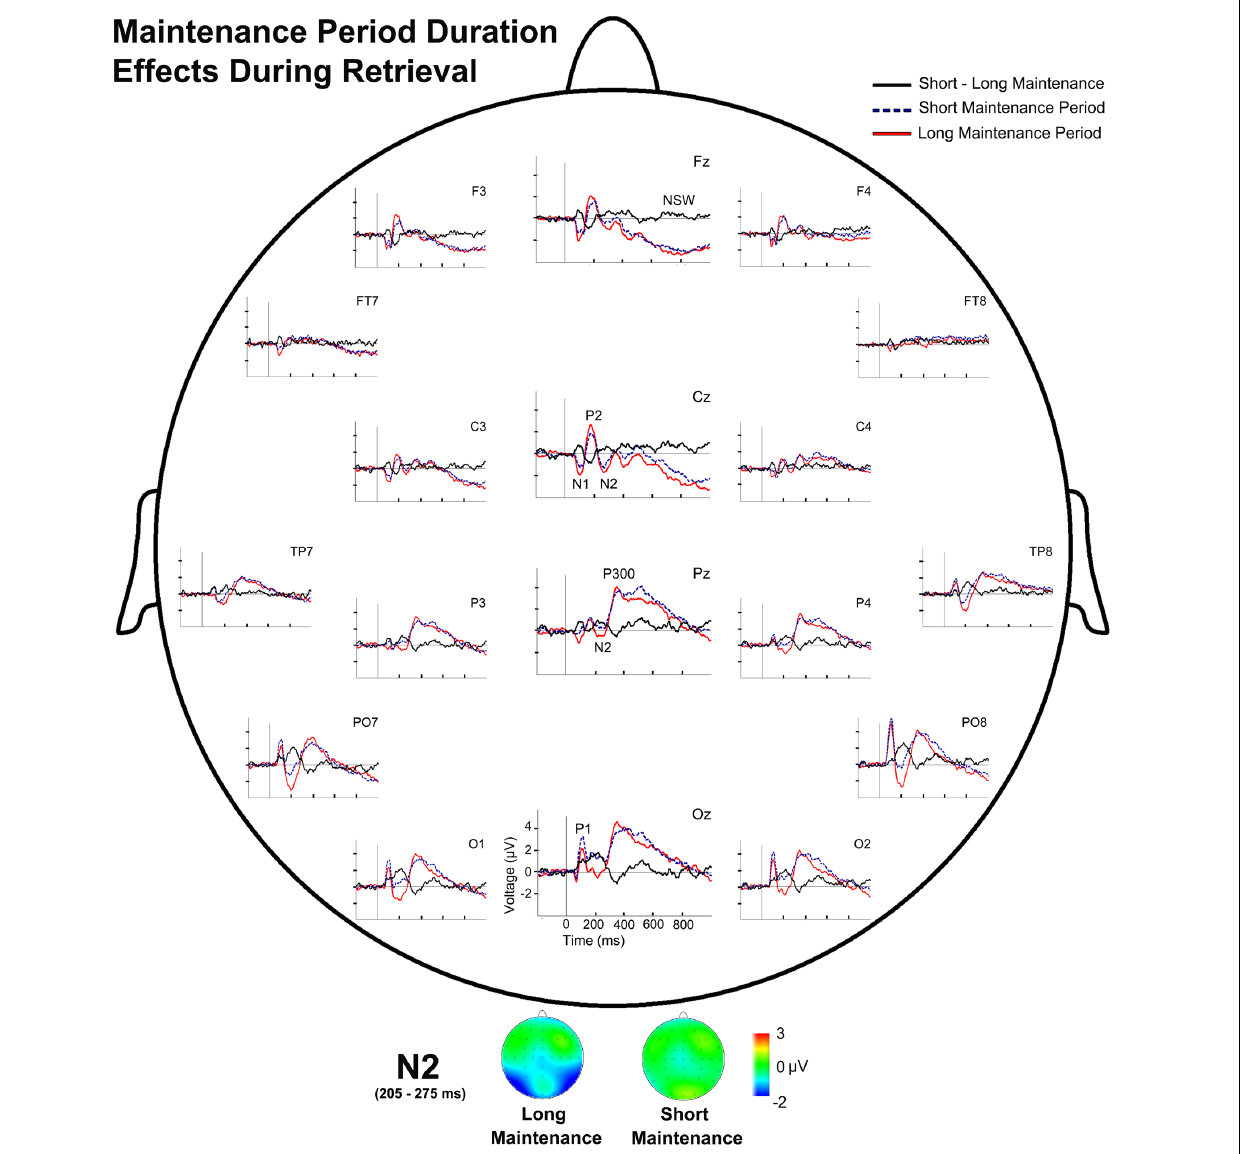
FIGURE 6 | Event-related potentials waveforms during probe stimulus processing and voltage maps for components modulated by maintenance period duration. (Top)Topographic plot of the ERP waveforms for both maintenance period duration conditions and their difference (SMP-LMP) during retrieval at several scalp electrodes. (Bottom) N2 voltage map for both maintenance period duration conditions during